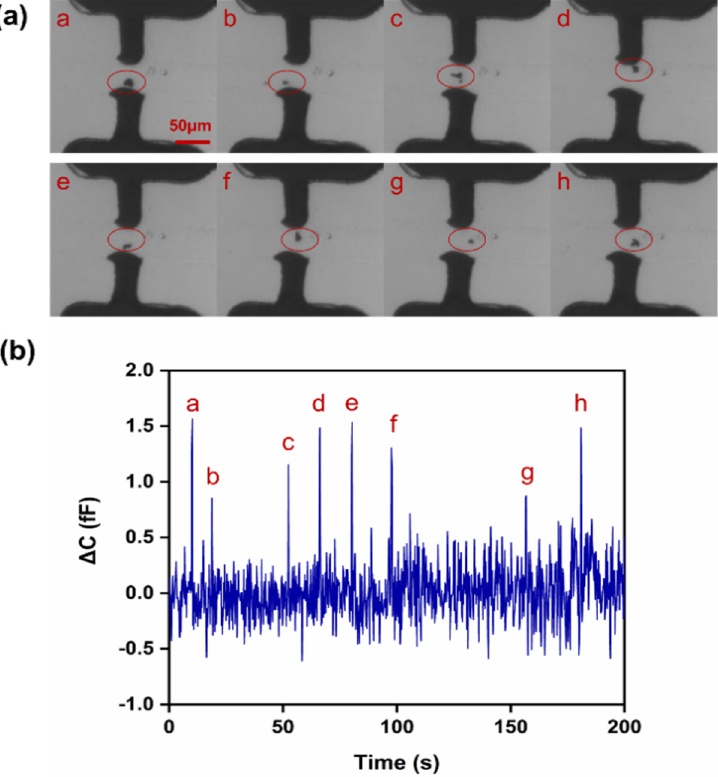
Figure 9. Metal particle counting in oil: ( a ) optical counting result of copper particles in oil over 200 s. Subfigures a–h indicate different copper particles passing through the electrodes, respectively; ( b ) the capacitance detection result of copper particles in oil over 200 s at 0.1 MHz.